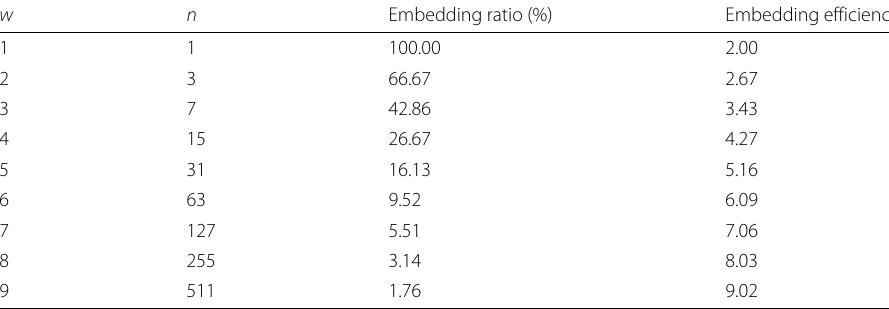
Table 2 Performance of matrix encoding with different parameters